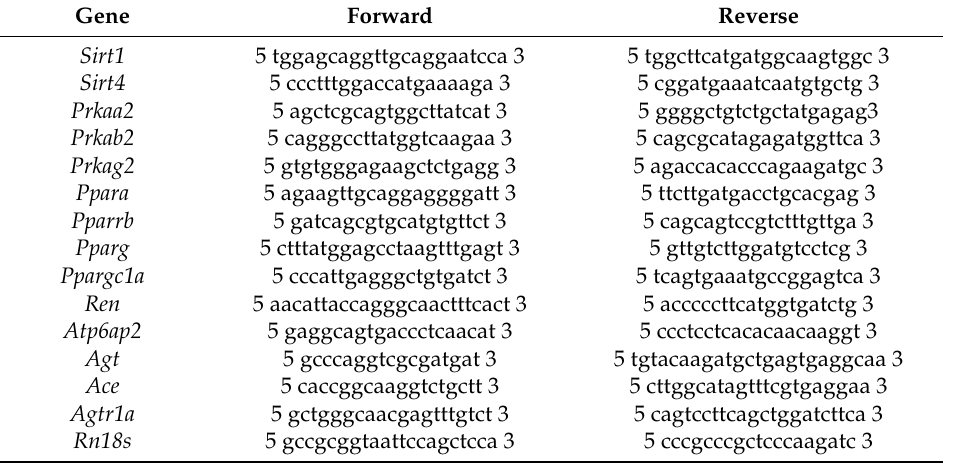
Table 3. Quantitative real-time polymerase chain reaction primers